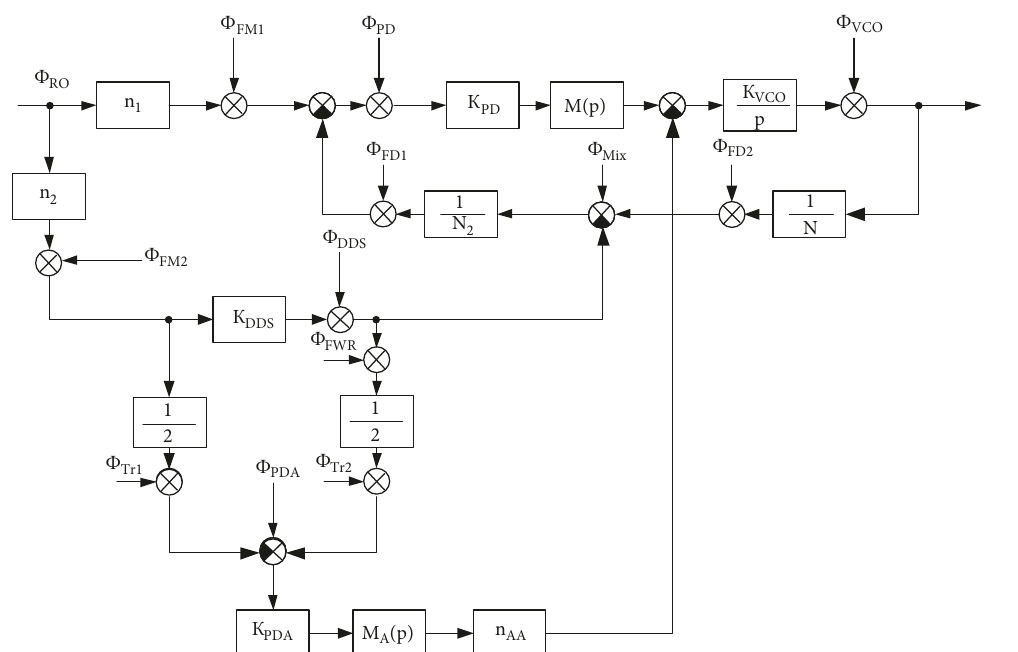
Figure 9: Equivalent circuitof the channelfor forming signals with the DDS as a support oscillator of the PLL with all sources of phase noises.